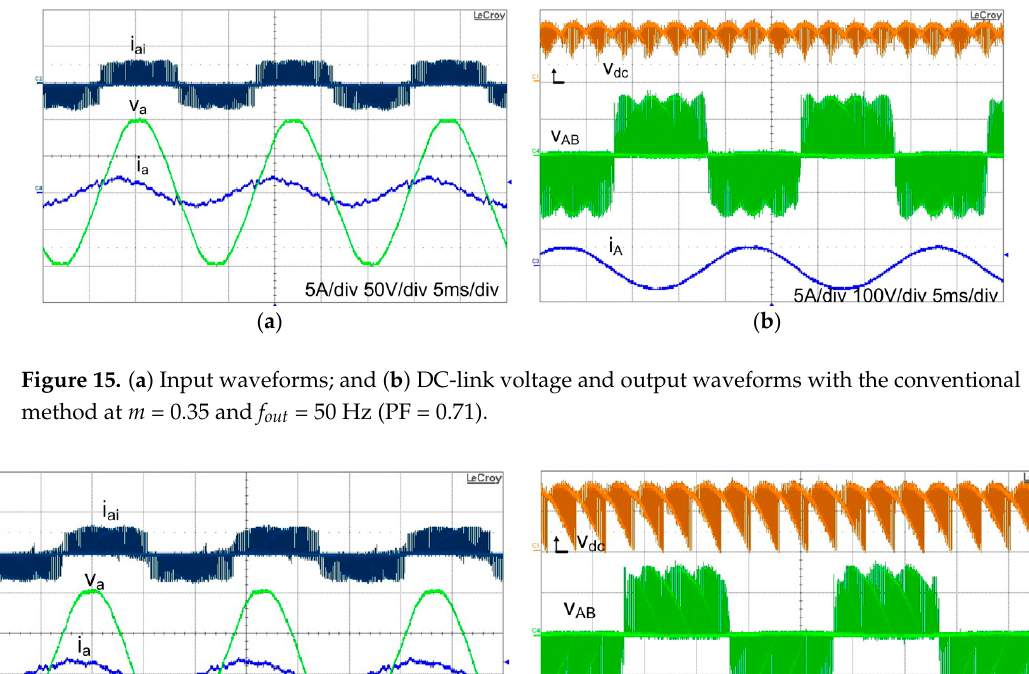
( b ) Figure 13. ( a ) Input waveforms; and ( b ) DC-link voltage and output waveforms with the conventional method at m = 0.6 and f out = 50 Hz ( PF = 0.94). ( a ) ( b ) Figure 14. ( a ) Input waveforms and ( b ) DC-link voltage and output waveforms with the proposed method at m = 0.6 and f out = 50 Hz ( PF = 1.0). Figures 15 and 16 show the experimental performance of the low voltage operation at voltage transfer ratio m = 0.35 and output frequency f out = 50Hz, with the conventional method and the